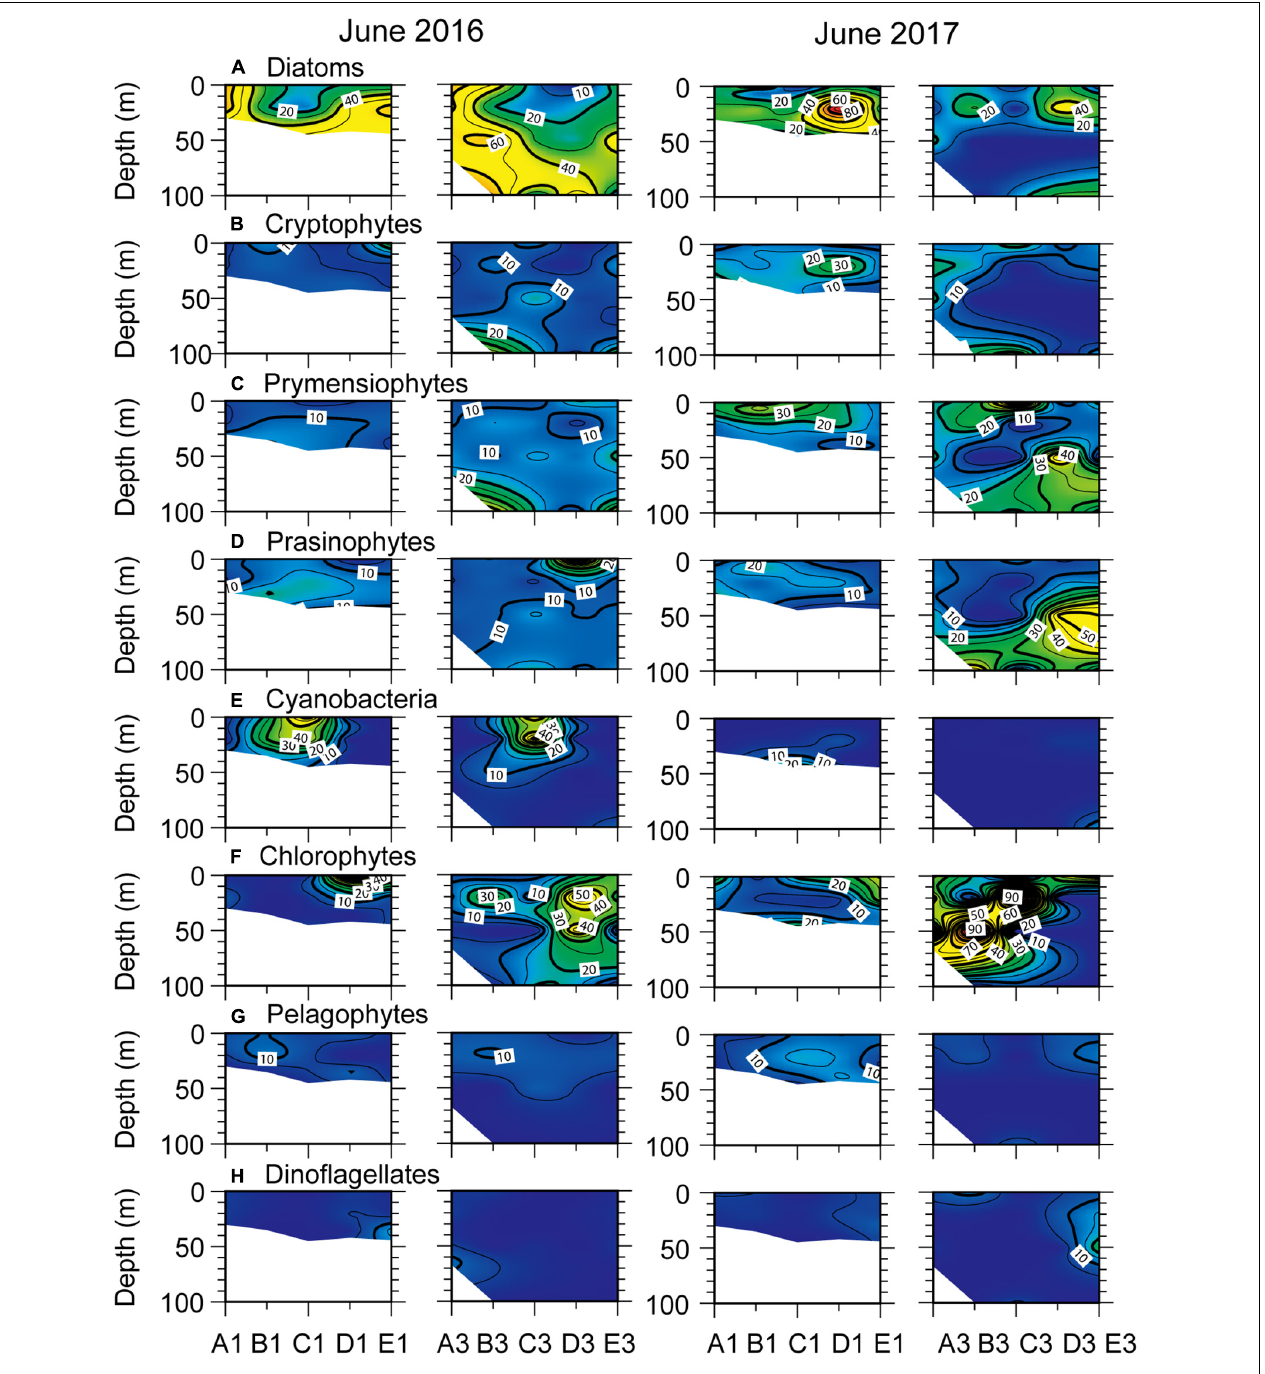
FIGURE 8 | Relative contribution (%) of different phytoplankton classes to total chlorophyll a as calculated by CHEMTAX across north–south longitudinal transects of nearshore (left) and offshore (right) stations (see Figure 1 ) in June 2016 and 2017. (A) diatoms, (B) cryptophytes, (C) prymnesiophytes, (D) prasinophytes, (E) cyanobacteria, (F) chlorophytes, (G) pelagophytes, and (H) dinoflagellates.